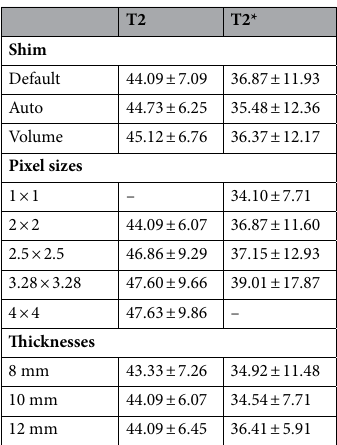
Table 5. Volunteers measurement of magnitude ± standard deviation for T2 and T2* sequences.